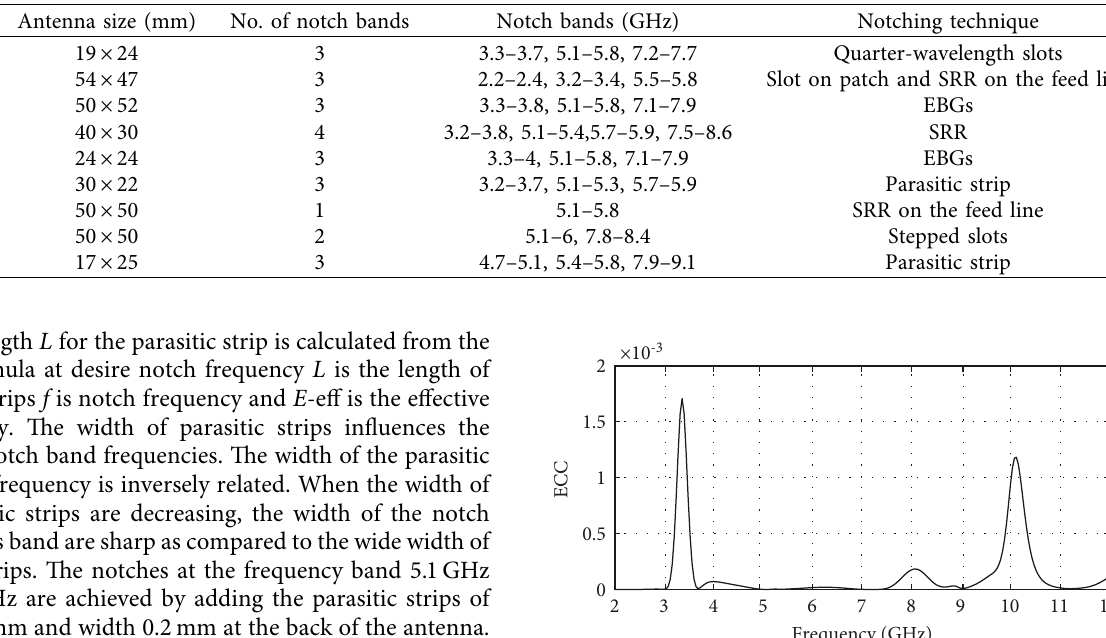
Table 2: Comparison of proposed design with existing techniques.